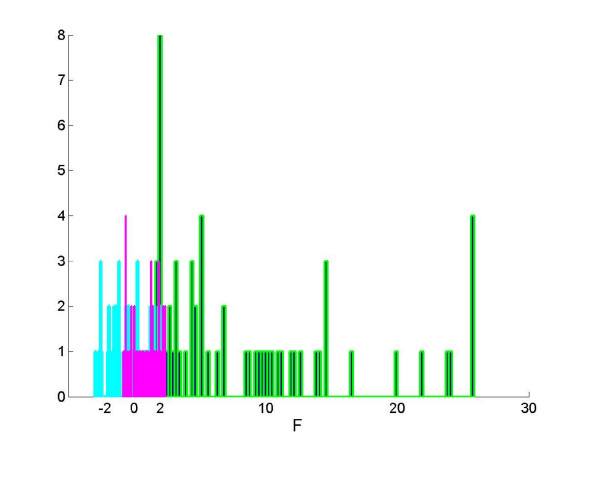
Histograms for regulatory (green), coding (cyan) and NCNR (magenta) sequences. The word length is 5, mismatch is 1, r is 50. The X axis shows the fluffiness coefficient F, the Y axis is the number of sequences in the set with this F.